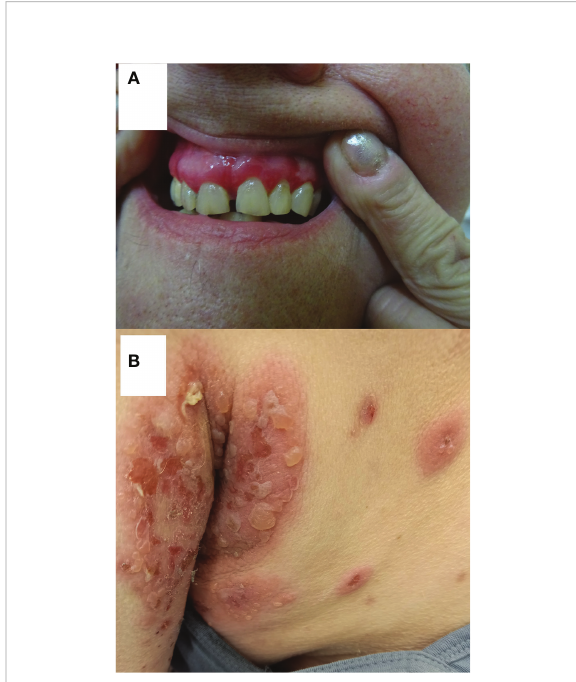
FIGURE 2 A middle-aged female with oral and cutaneous lesions plausibly related to nivolumab therapy for melanoma and mRNA vaccination for COVID-19 who could be diagnosed as mucous membrane pemphigoid/bullous pemphigoid (IgG anti-BP180 NC16A). Stubborn desquamative gingivitis (A) . Itchy urticarial and blistering lesions on armpit skin (B) . Reprinted/adapted with permission, Dmochowski M. Autoimmune bullous diseases associated with malignancy. 31st EADV Congress: Designing the Future of Dermatology and Venereology. Italy: Milan (2022)